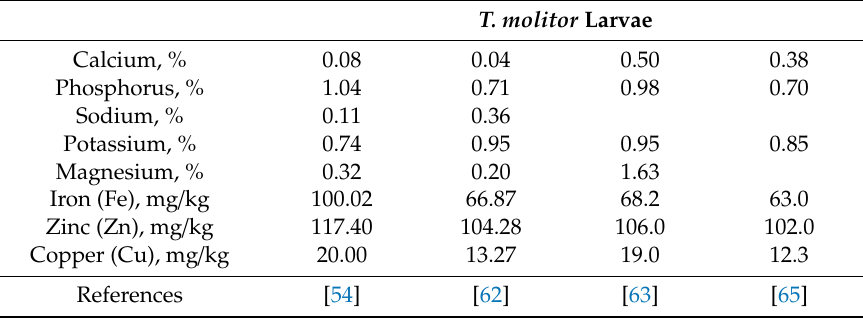
Table 4. The mineral contents of Tenebrio molitor larvae (DM